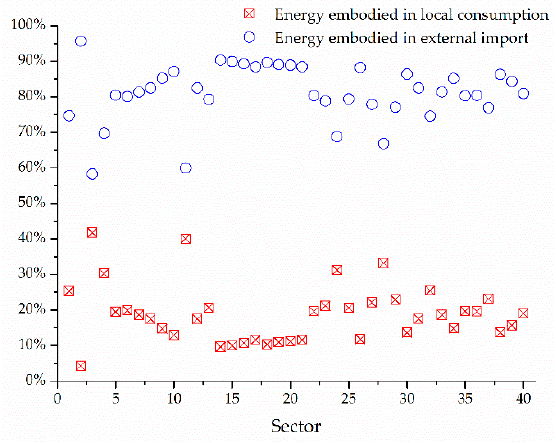
Figure 5. Proportion of the EEI embodied in local consumption and external transfer in 2012.